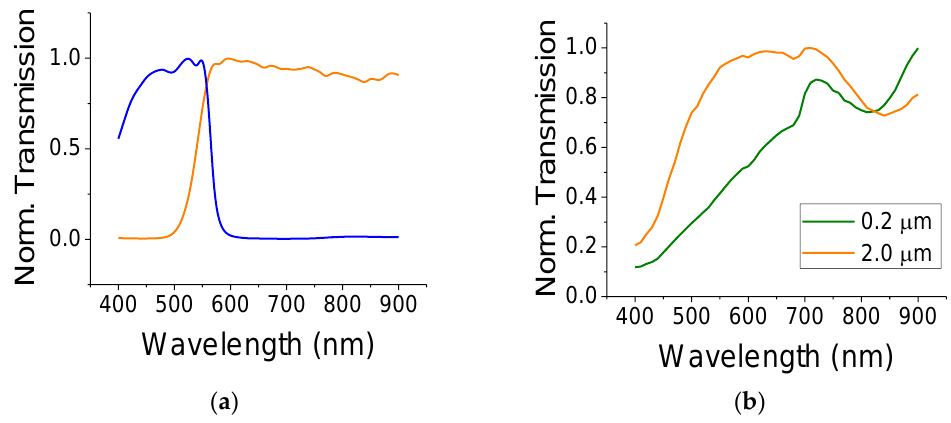
Figure 2. ( a ) Normalized transmission through the optical filters used in the experiments: a short- pass wavelength (blue) and long-pass wavelength (yellow) filters. ( b ) Normalized transmission through films composed of the smaller (0.2 µm) and larger (2 µm) particles of TiO 2 . The particles were embedded in a thin PMMA matrix.